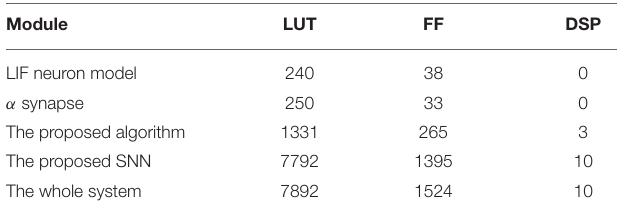
TABLE 3 | The hardware resource cost of the proposed